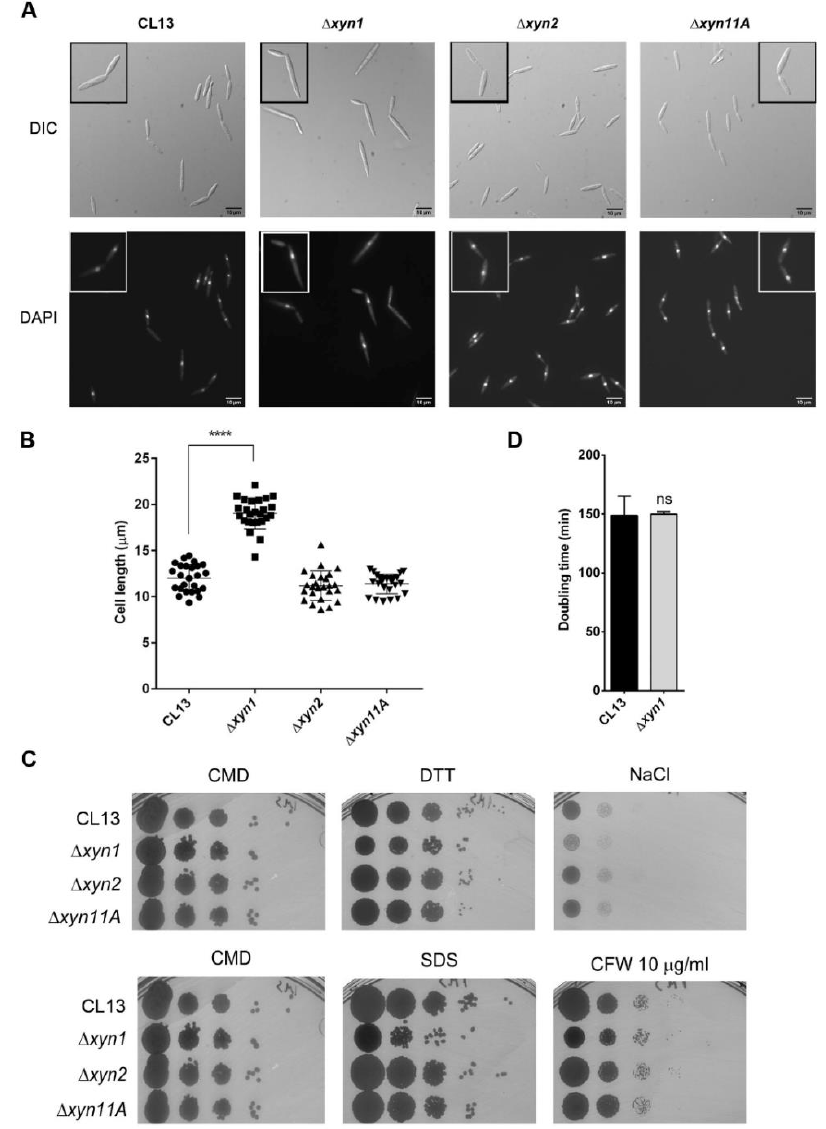
Figure 3. Effects of xylanase gene deletion on axenic growth. ( A ) Nuclei of exponential phase cells stained with DAPI. Scale bars represent 10 µ m. ( B ) Length of CL13 wild-type, ∆ xyn1 , ∆ xyn2 and ∆ xyn11A strains was measured in rich media culture at exponential phase. Quantification was carried out for 25 cells. T-test statistical analysis was performed (**** p -value < 0.001). ( C ) Spot tests to assay ER stress (DTT), osmotic stress (NaCl), cell membrane and oxidative stress (SDS), and cell wall integrity (CFW). Rich media (CMD) without drug was used as growth control. ( D ) Doubling time was calculated from growth curve performed in triplicate using rich media. T-test statistical analysis was performed (ns, not statistically significant).